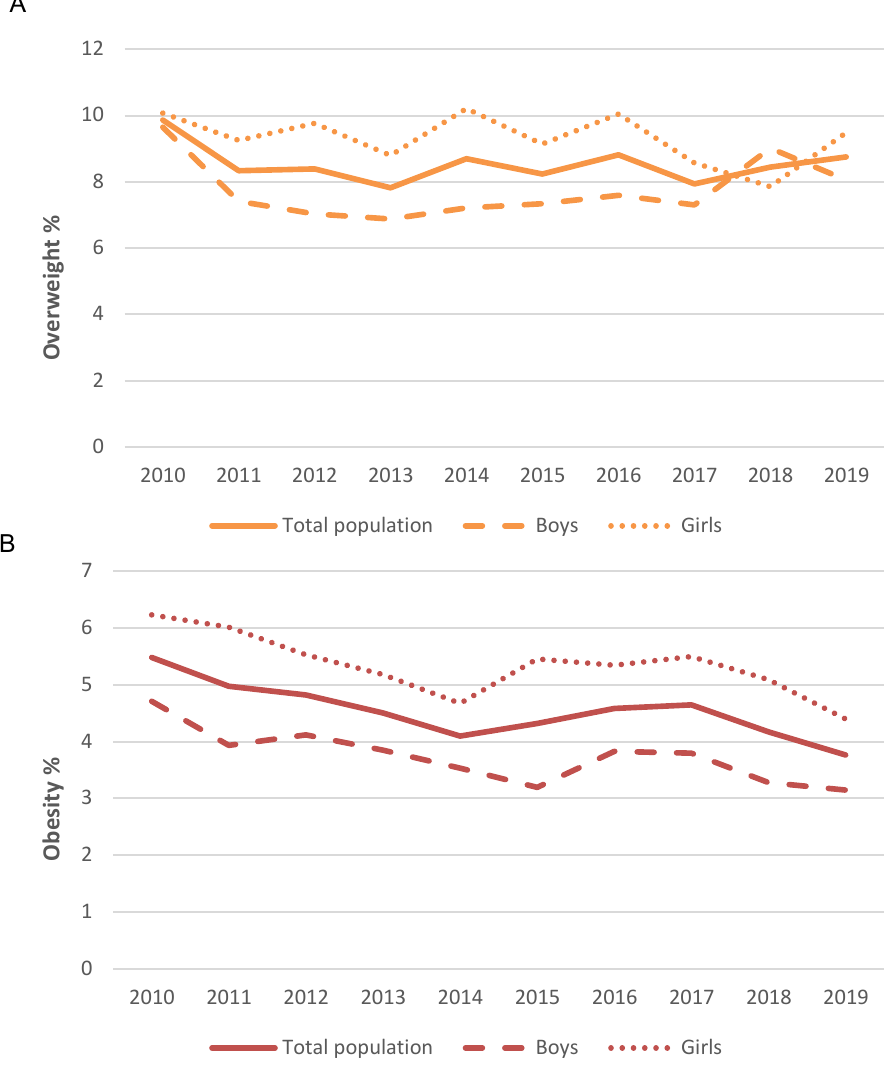
Figure 2. Prevalence of overweight ( A ) and obesity ( B ) among Spanish children by Faustino Orbegozo Foundation (OF)criteria in the 2010–2019 timeframe.